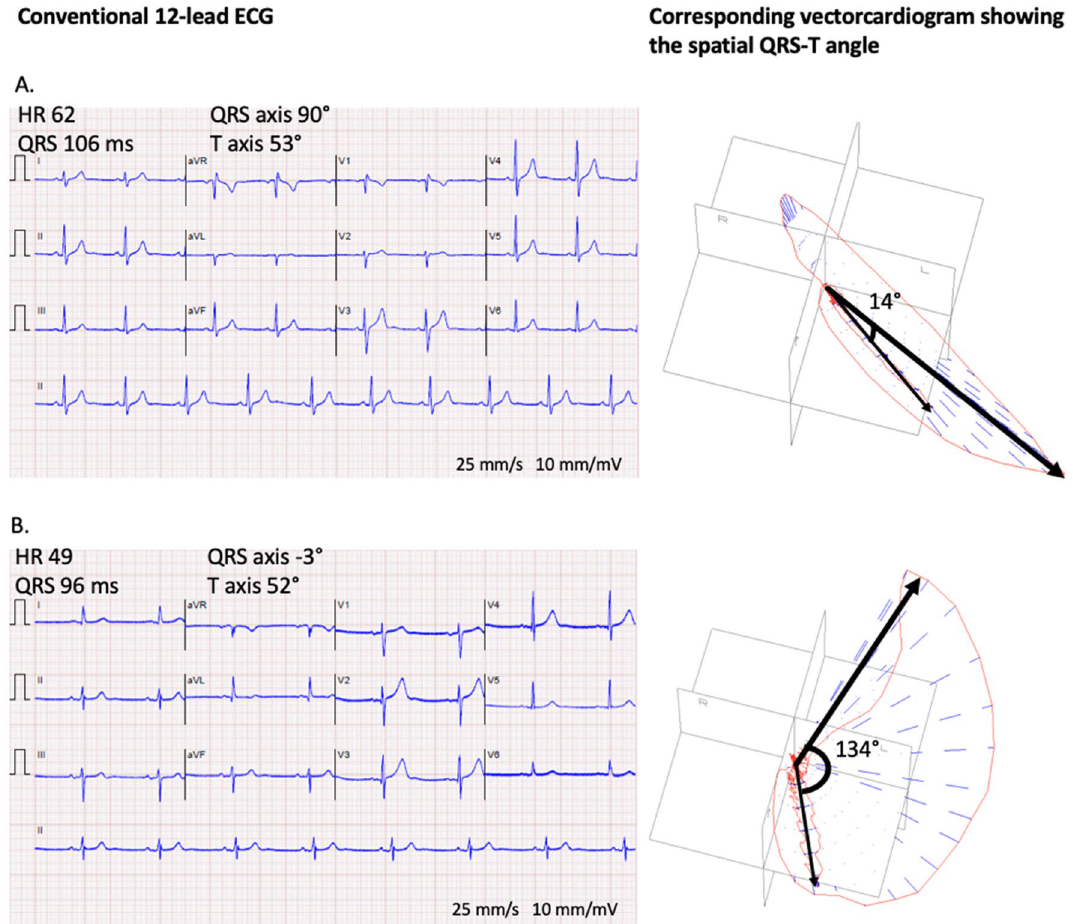
Figure 2. Two representative examples of different QRS-T angles from the study. ( A ) A normal conventional 12-lead ECG in a healthy male in their 50s, with a corresponding derived vectorcardiographic spatial peaks QRS-T angle of 14° (normal). ( B ) A normal conventional 12-lead ECG in a male in their 80s with imaging- proven LVH, with a corresponding derived spatial peaks QRS-T angle of 134° (abnormal). HR denotes heart rate. Note, the QRS axis and T axis noted in the figure are from the frontal plane, whereas the spatial peaks QRS-T angle is calculated in three-dimensional space from the derived